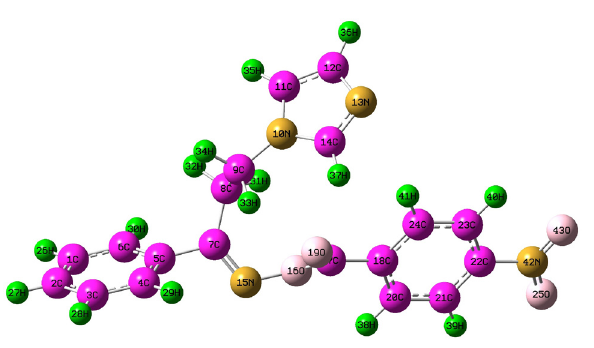
Figure 1: The optimized possible geometric structure with atoms numbering of the IPAONM molecule.